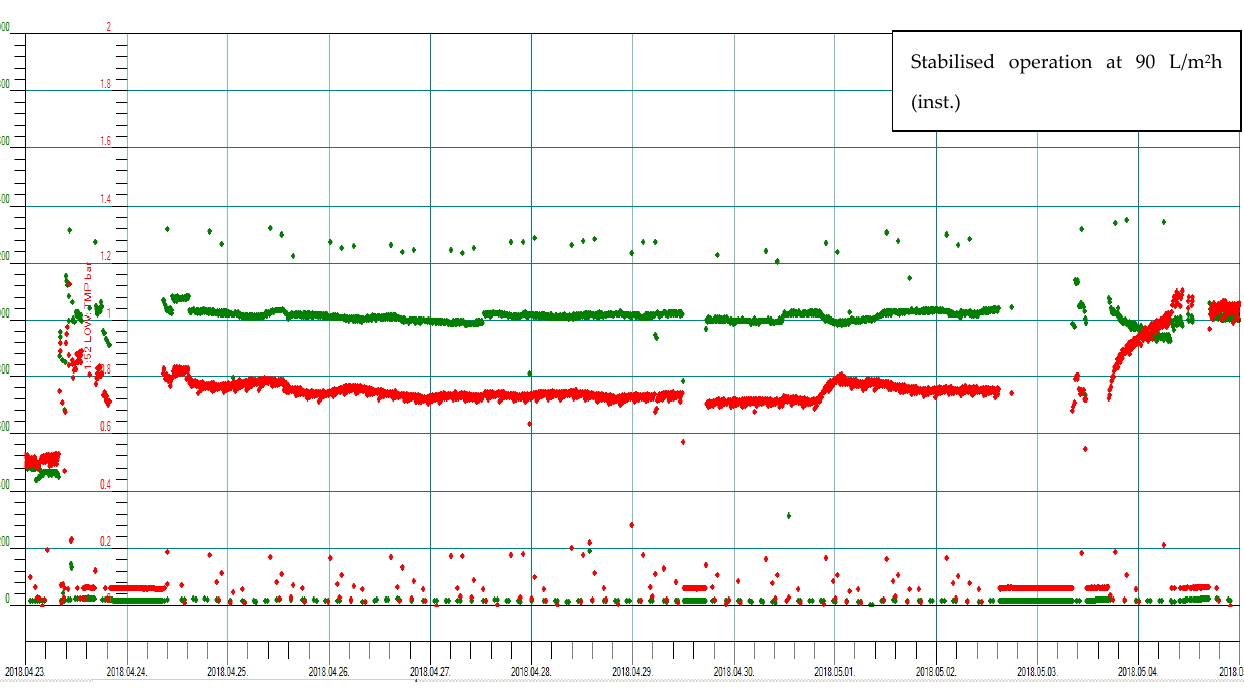
Figure A7. Flow and temperature.